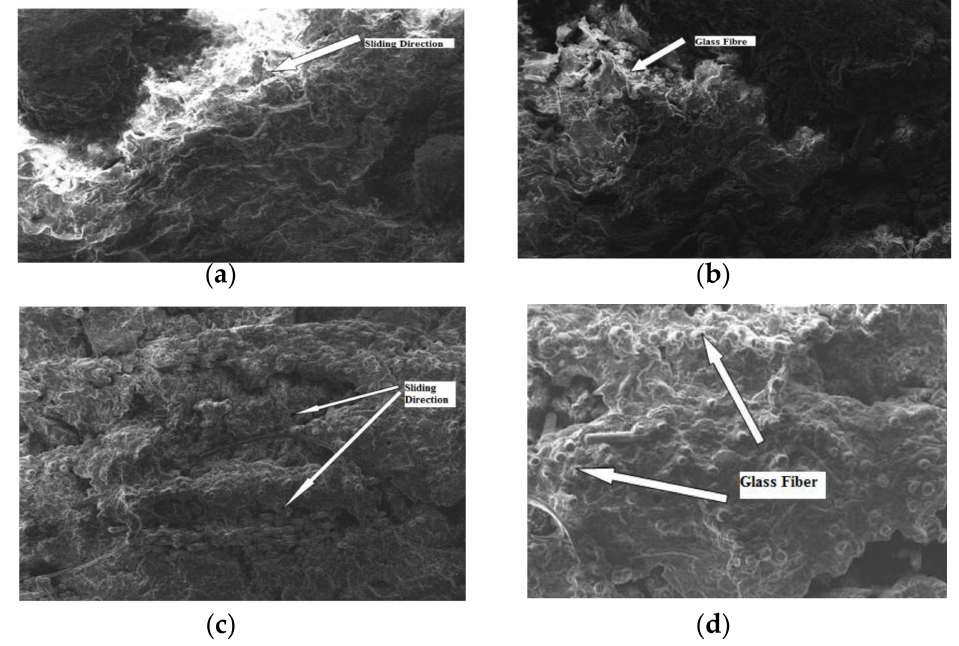
Figure 8. SEM image of worn surfaces of the GFRPA66 30 wt.% and GFRPA66 35 wt.%, at a load of 80 N: ( a ) GFRPA66 30 wt.%, 0.16 m/s; ( b ) GFRPA66 30 wt.%, 0.22 m/s; ( c ) GFRPA66 35 wt.%, 0.16 m/s; ( d ) GFRPA66 35 wt.%, 0.22